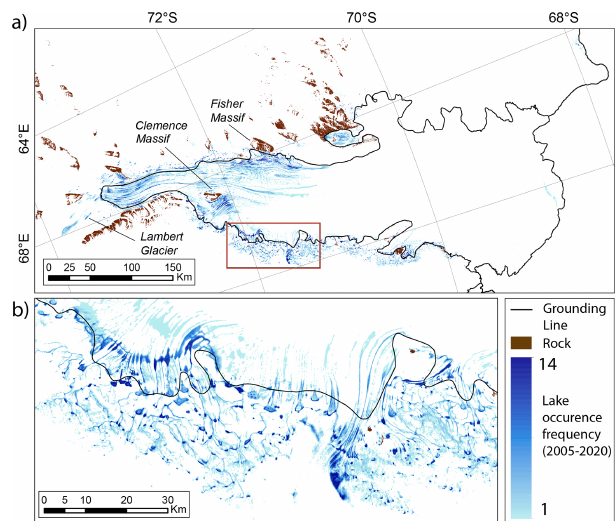
Figure 6. Spatial distribution of SGLs over the study region, show- ing the recurrence frequency of surface meltwater between 2005 and 2020. The maximum recurrence frequency is 14, due to the exclusion of the 2004/05 and 2018/19 melt seasons. Pixels were assigned values of 1 (melt) or 0 (no melt) per year, based on the occurrence of surface water at any stage during each melt season. Pixels were then summed to derive recurrence frequency. The lin- ear light blue feature near the ice shelf calving front is a misclas- sification error associated with a large calving event that occurred in September 2019 (Walker et al., 2021). The spatial distribution of lakes in a high-melt (2005/06) and low-melt (2010/11) season are shown in Supplement Figs. S6 and S7